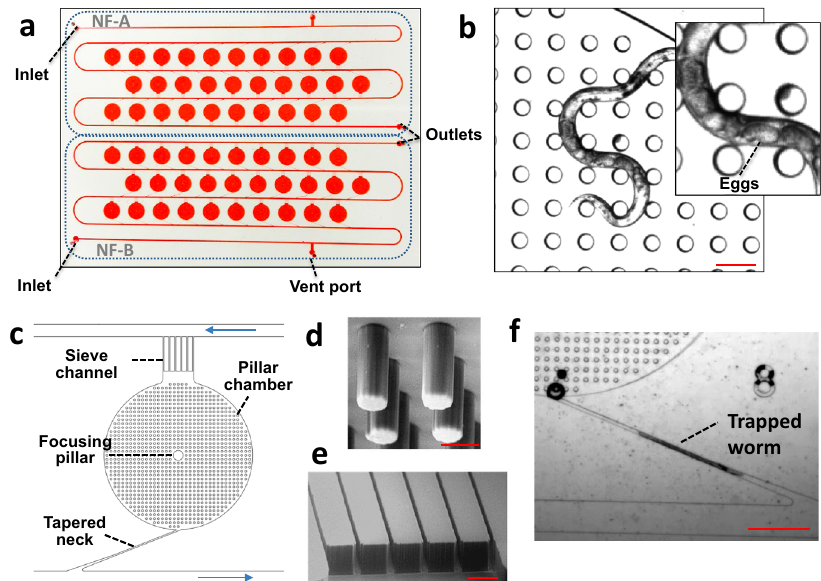
Fig. 3 Design of the NemaFlex-S device for strength measurement of C. elegans . a An actual image of the NemaFlex-S device with two identical sections NF-A and NF-B, the device is fi lled with red food dye for better visualization of the salient features. b Image of a gravid adult crawling in the pilar chamber. The zoomed inset image shows the eggs inside the worm. Scale bar, 100 µm. c Design of the individual pillar chamber. The chamber is connected to the fl ow channel (highlighted with blue arrows) with a tapered neck for trapping the worms and with sieve channels for removing the progenies. d Scanning electron microscopy (SEM) image of deformable micropillars. Scale bar, 50 µm. e SEM image of sieve channels. Scale bar, 100 µm. f Image of an adult worm trapped in the neck Scale bar, 500 µm. See Supplementary Video for trapping and loading of an adult into the chamber. Images used in this fi gure were captured at